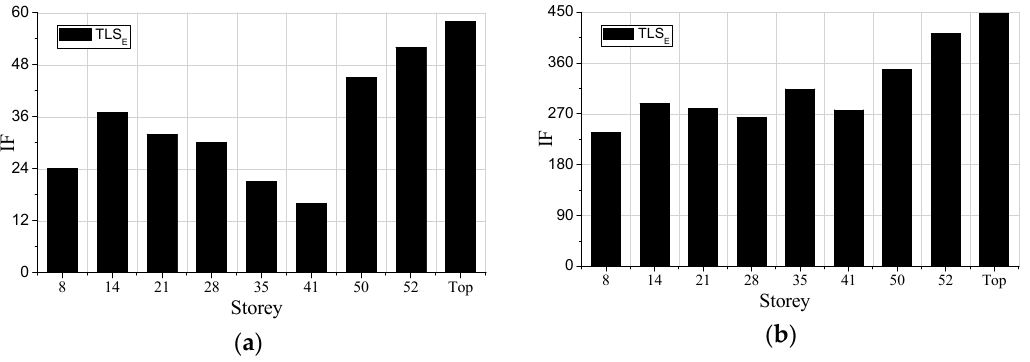
Figure 11. Identification factors (Ifs) along with stories: ( a ) Frequent 6; ( b ) Rare 7.